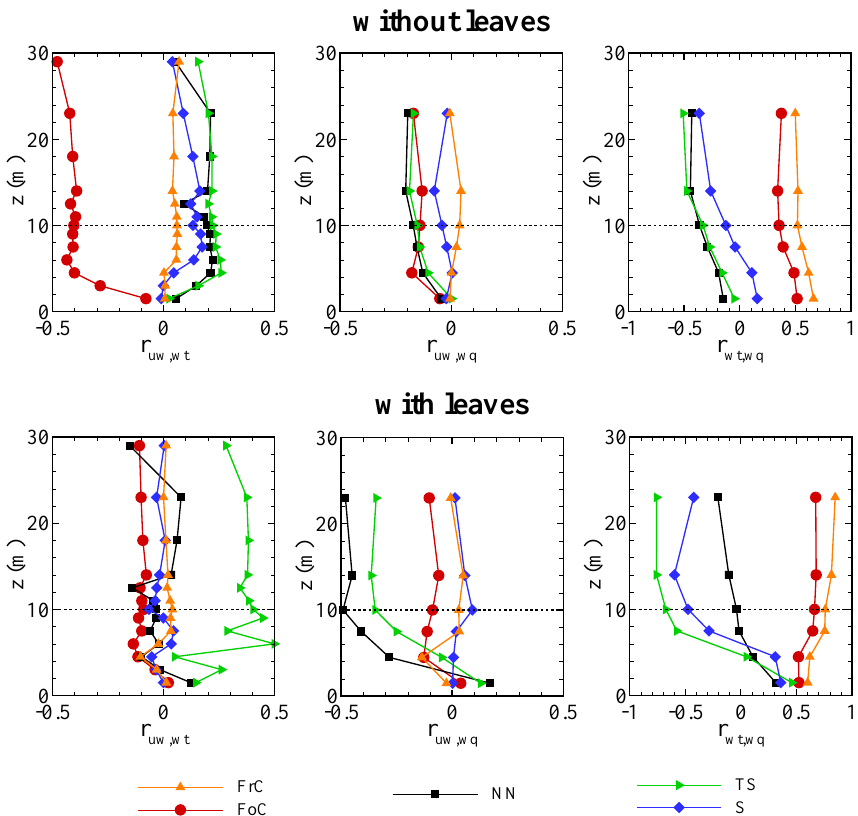
Fig. 5. Vertical profiles of mean correlation coefficients between momentum and heat fluxes ( r uw,wt ), momentum and water vapor fluxes ( r uw,wq ), and heat and water vapor fluxes ( r wt,wq ), for all five stability regimes and for both seasonal periods. The dashed line indicates the canopy